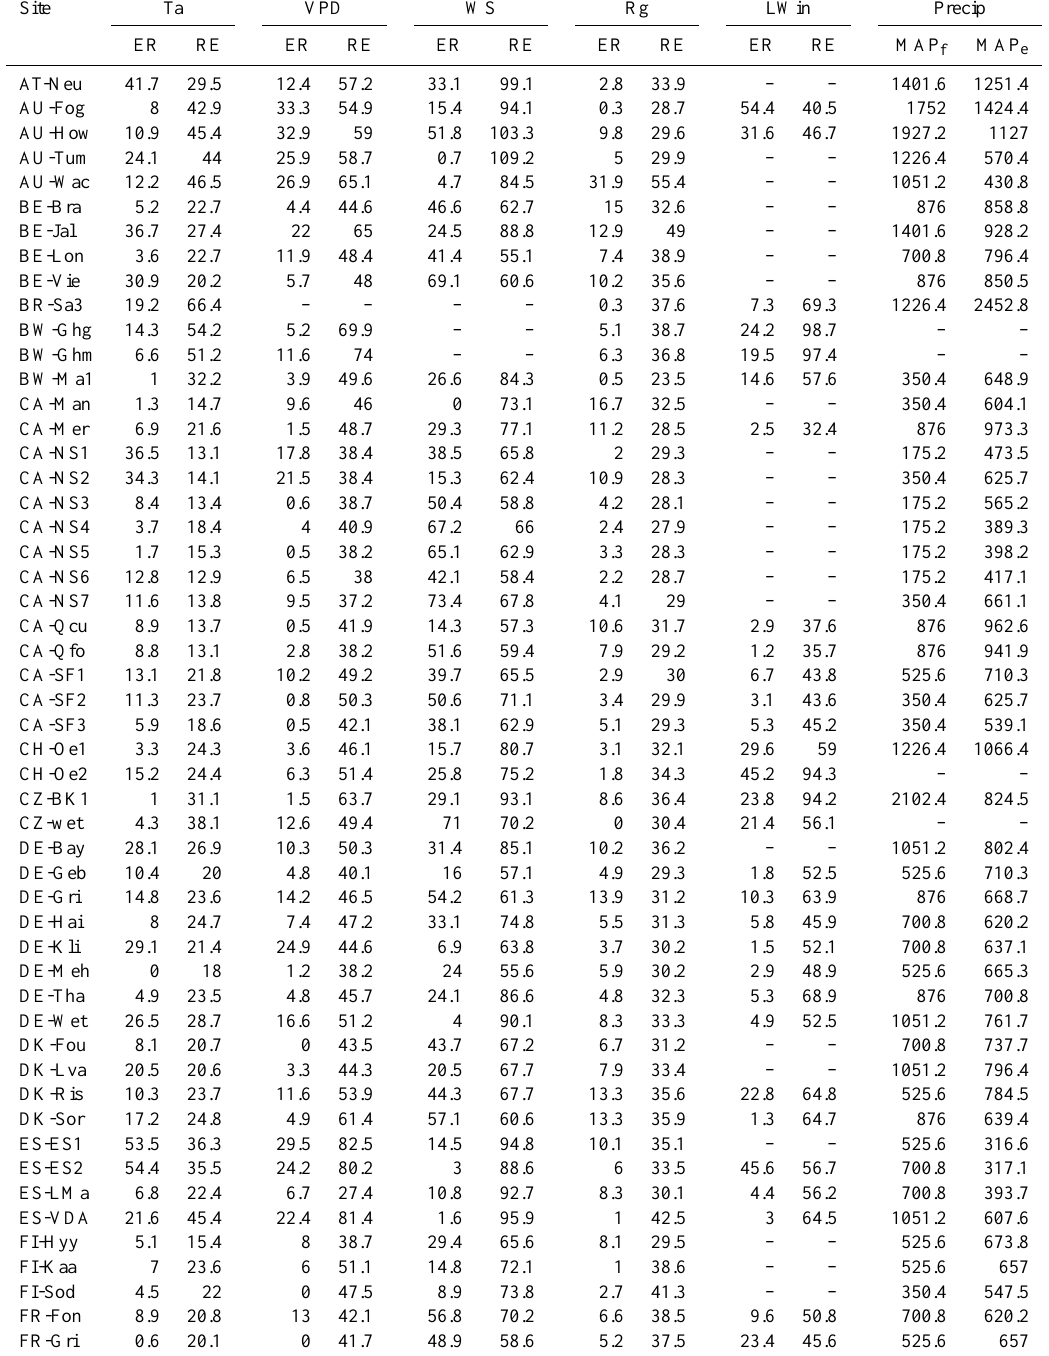
Table B1. Error reduction (ER, %) and relative error (RE, %) of the bias correction method for air temperature (Ta), vapour pressure deficit (VPD), wind speed (WS), global radiation (Rg), longwave incoming radiation (LWin) and mean annual precipitation (mm yr − 1 ) as measured at FLUXNET stations (MAP f ) and as given by the ERA-I product (MAP e